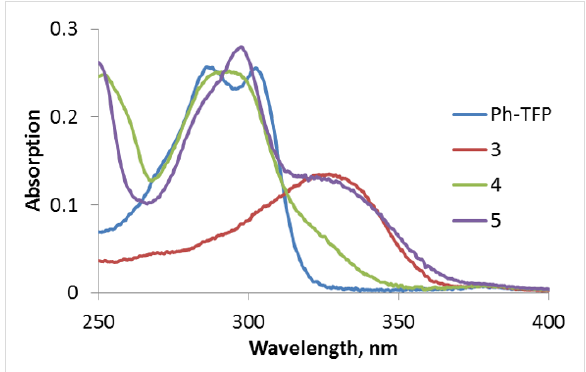
Figure 6: Absorption spectra of three isomers, 3 , 4 , 5 , and Ph-TFP in acetonitrile (10 μ